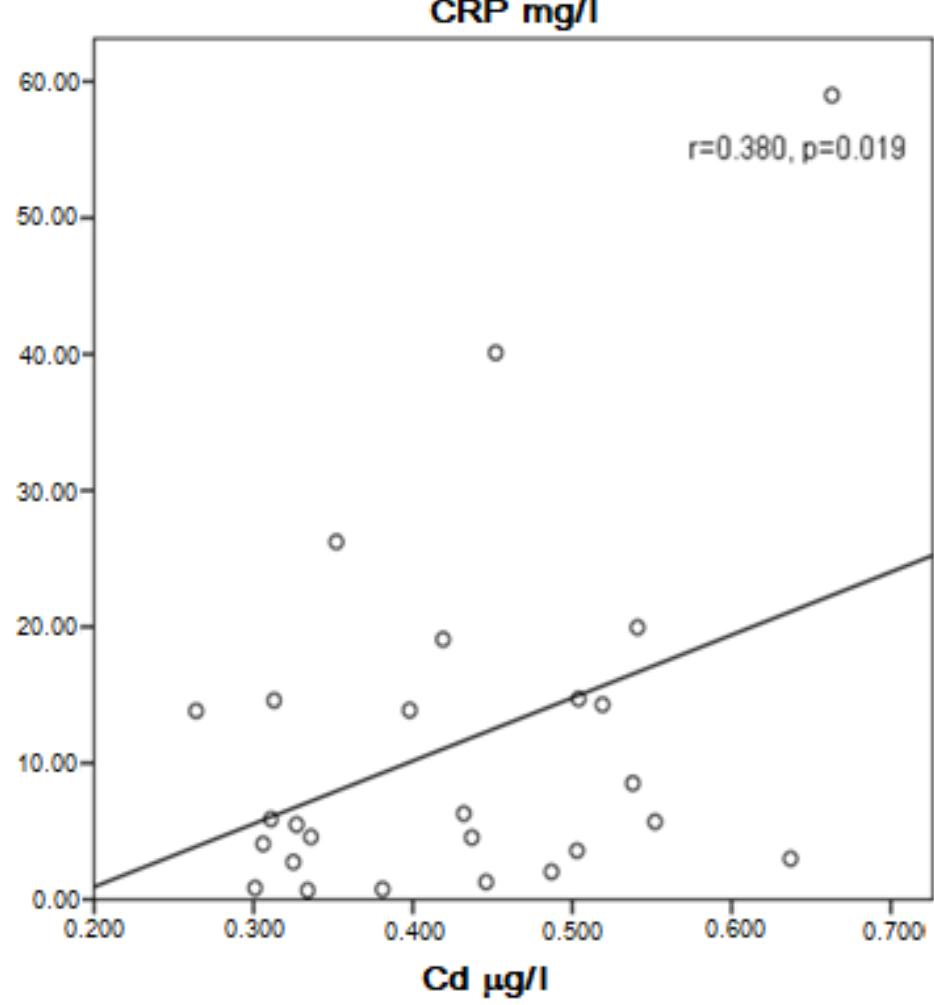
Figure 1. Correlation of Cd and CRP in COPD